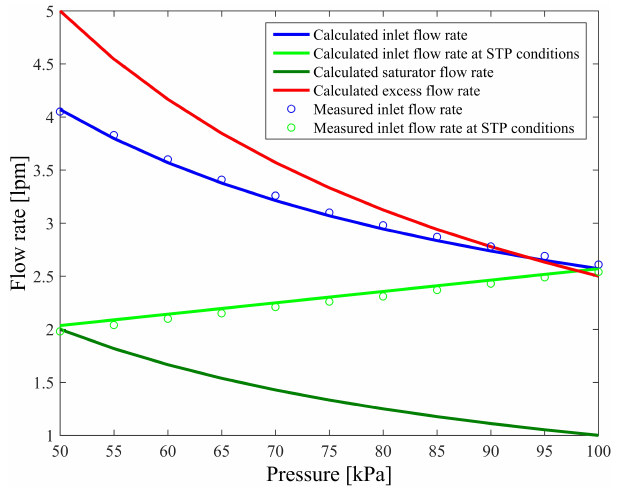
Figure 5. The detection efficiency of the nCNC measured at dif- ferent pressures for 50nm ammonium sulfate particles. The blue circles are the uncorrected data, the red data were corrected with the calculated dilution correction, the black data were corrected for the CPC under-counting and the green data were corrected for both effects. Curves have been normalized to unity at normal pressure to separate the two corrections. Green data points can only be reached by correcting the measured data with these two